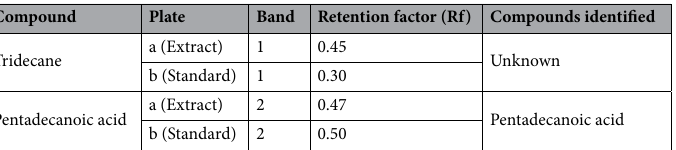
Table 9. Retention factor determined by TLC for Globitermes sulphureus defense fluid, calculated from plate a and compared to the retention factor of the standard in plate b.